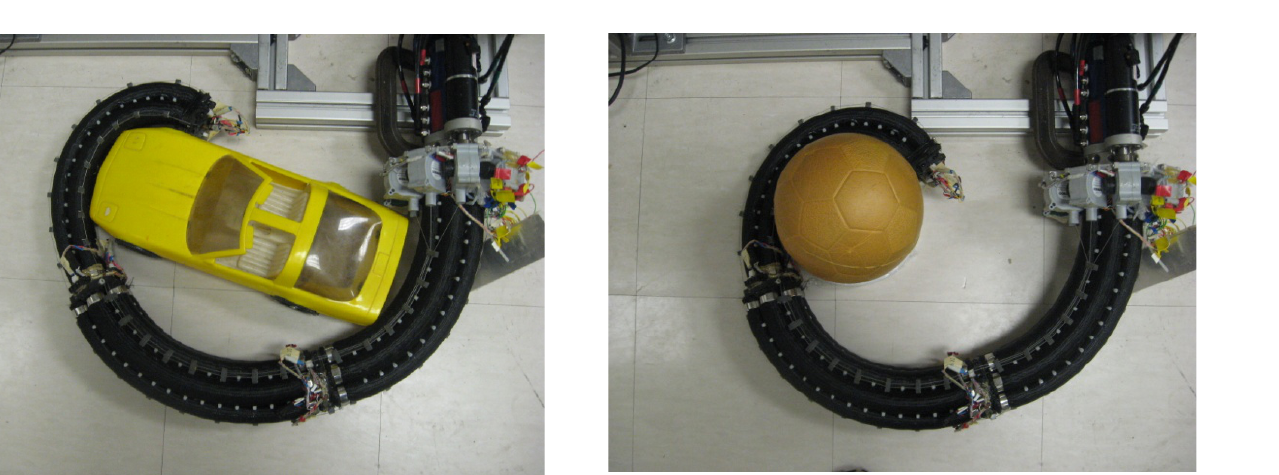
Figure 9. Grasping fragile objects – using a parallel jaw gripper (unsafe grasp) and the Octarm